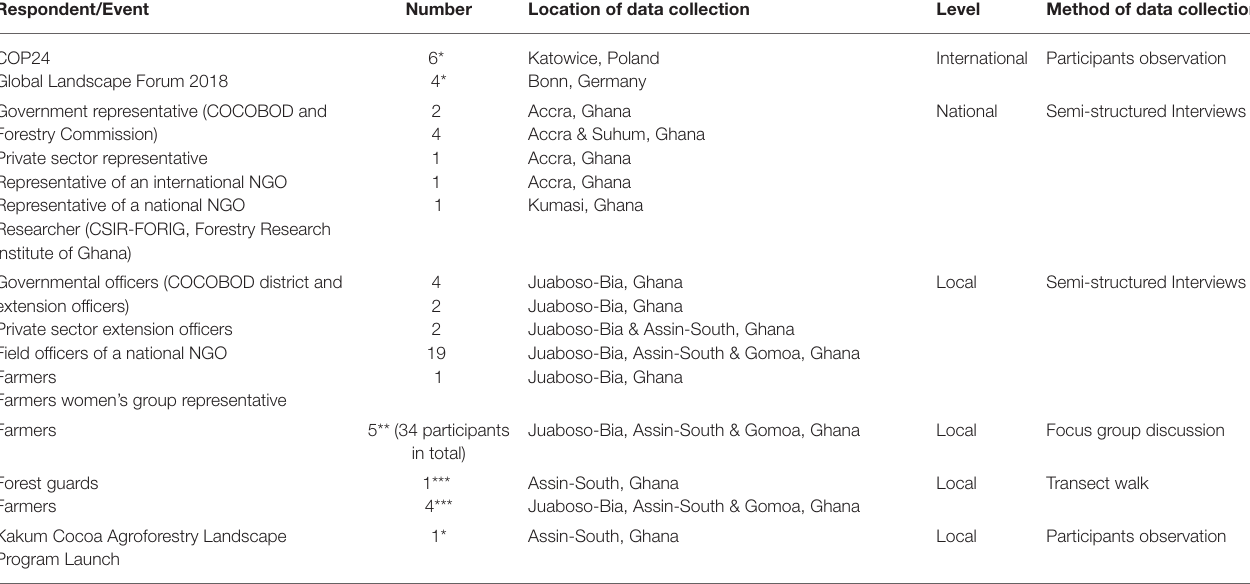
TABLE 1 | Overview of data